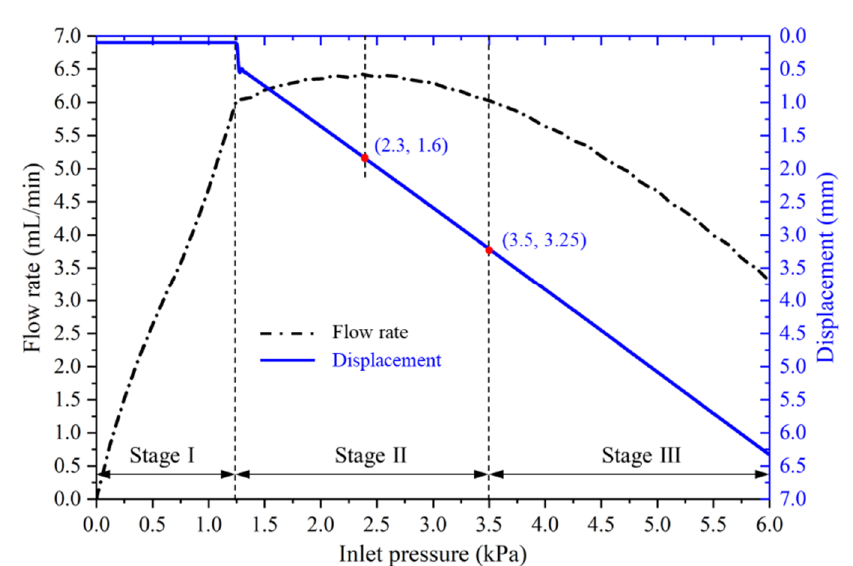
Figure 7. Displacement of the vale core under varied inlet pressures.